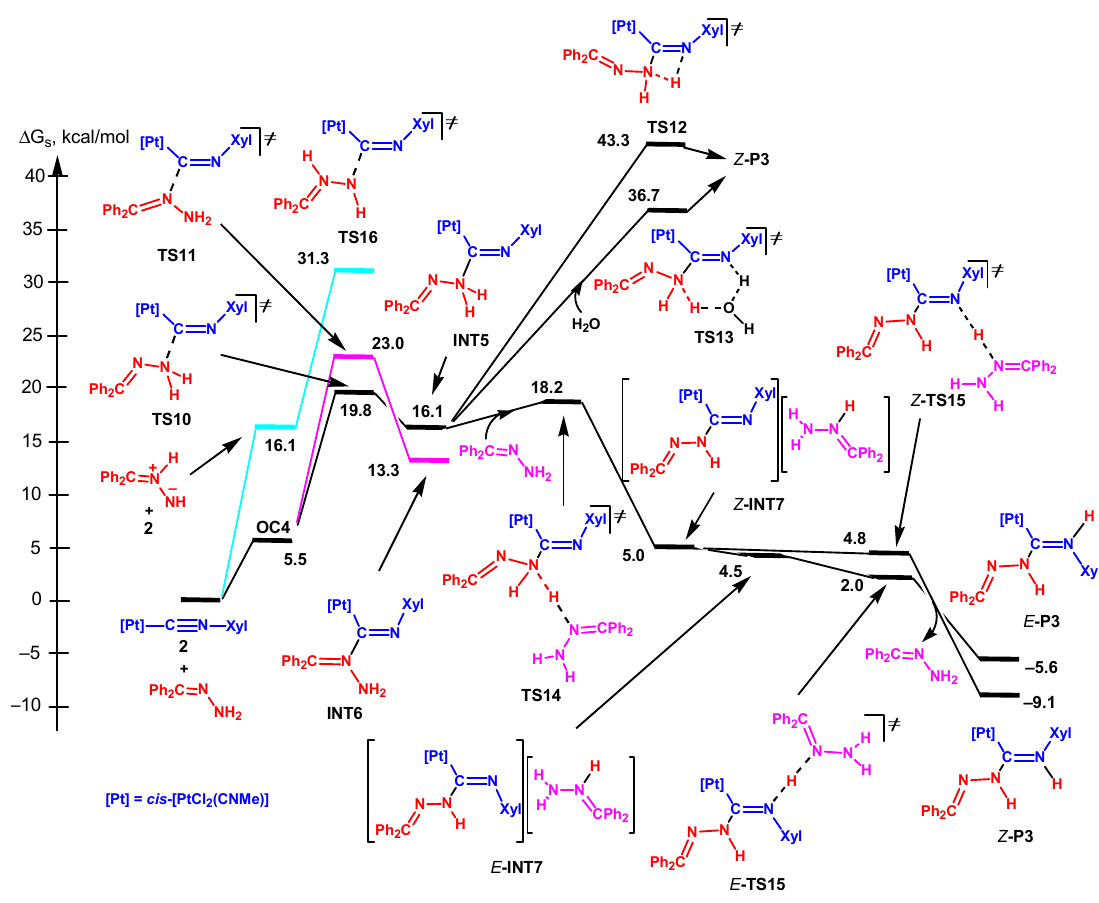
Figure 5. Energy profile for the associative mechanism of nucleophilic addition of H 2 N–N=CPh 2 to the C ≡ NXyl ligand in cis -[PtCl 2 (C ≡ NMe)(C ≡ NXyl)].